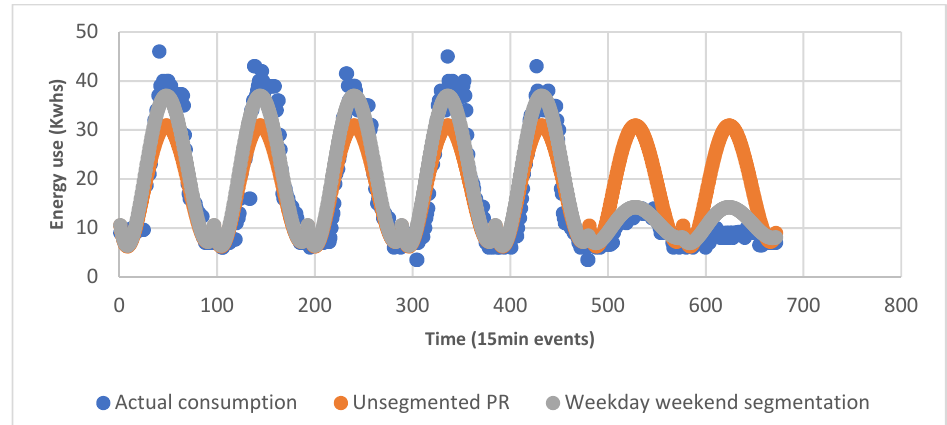
Figure A6. A comparison of weekday and weekend segmented weekly PR prediction, to actual consumption and the unsegmented predicted consumption, in the first week of autumn.